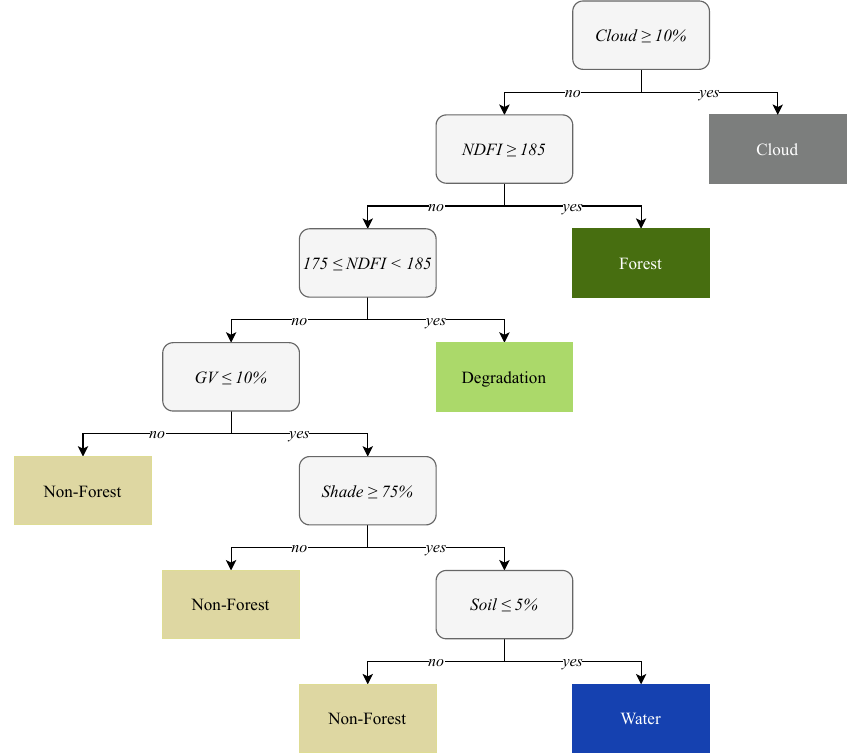
Figure 5. Decision tree for mapping Non-Forest, Forest, Degradation, Water and Cloud (adopted from